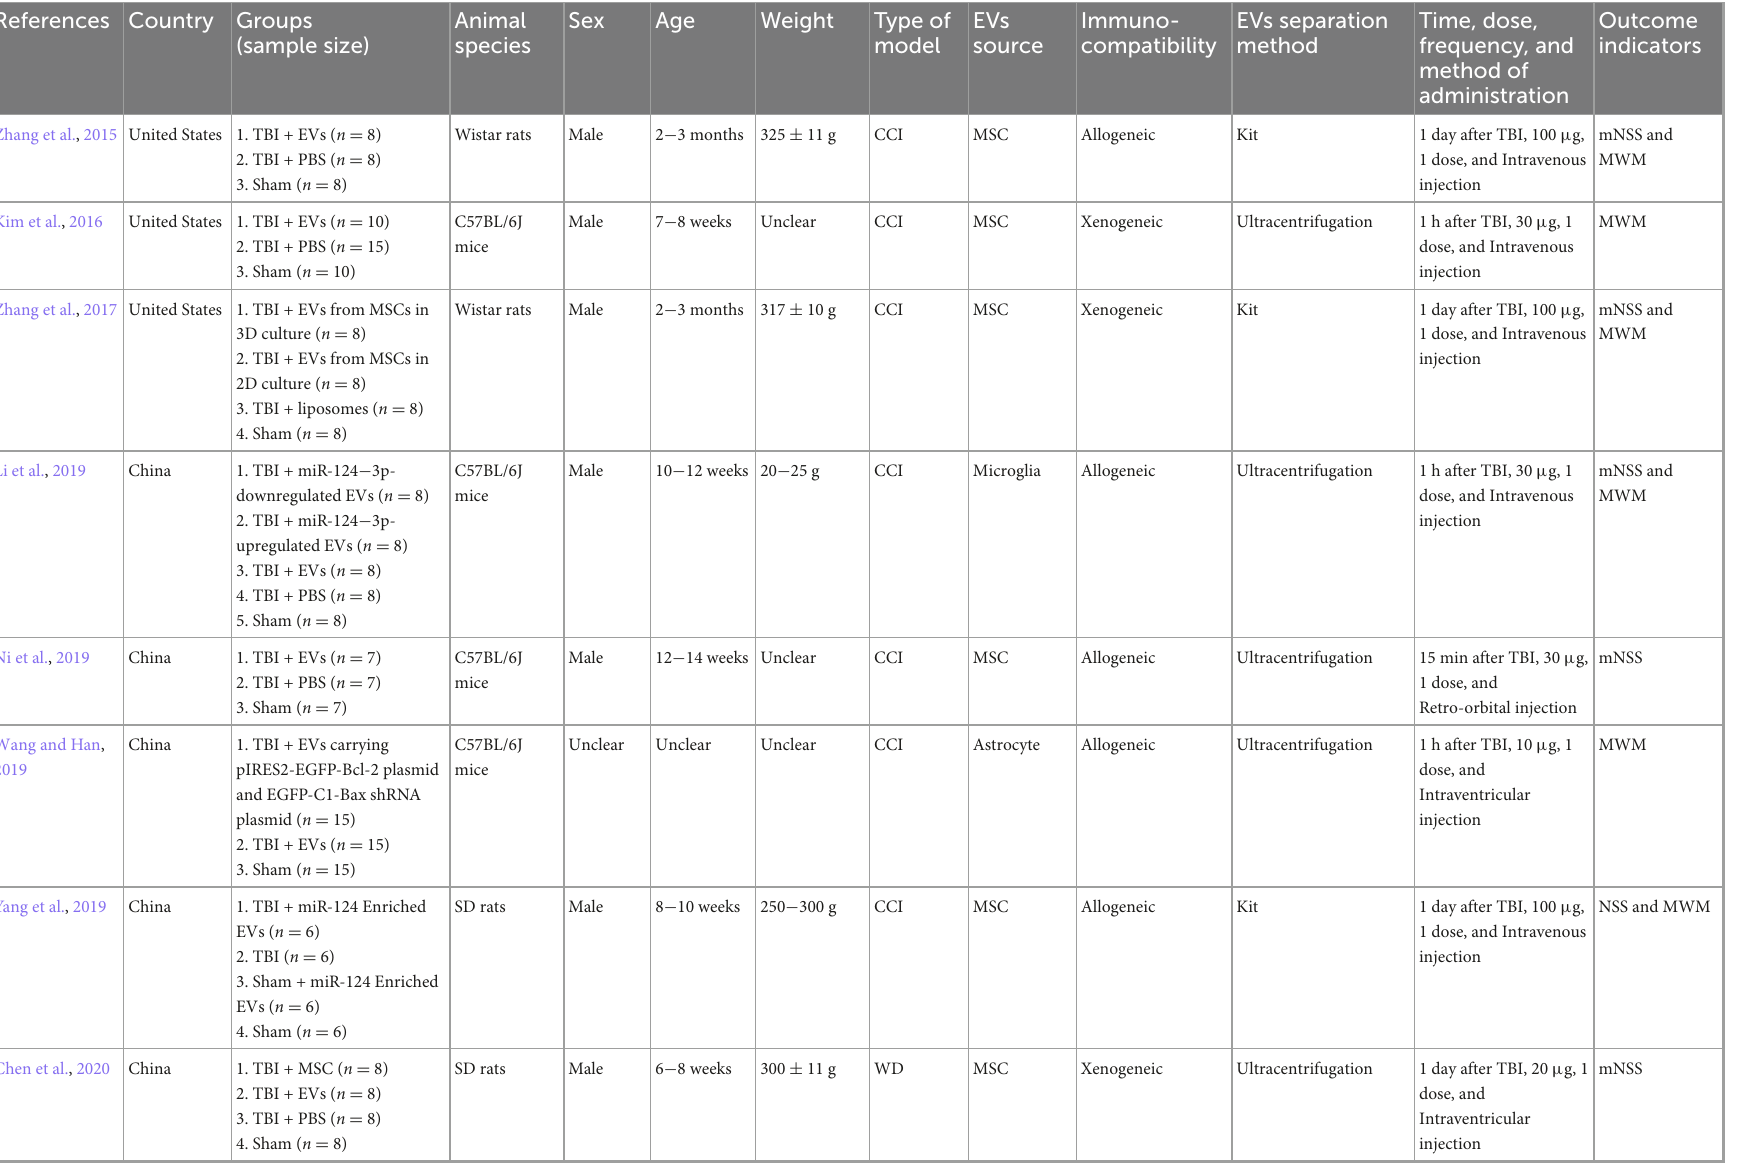
TABLE 1 Characteristics of included